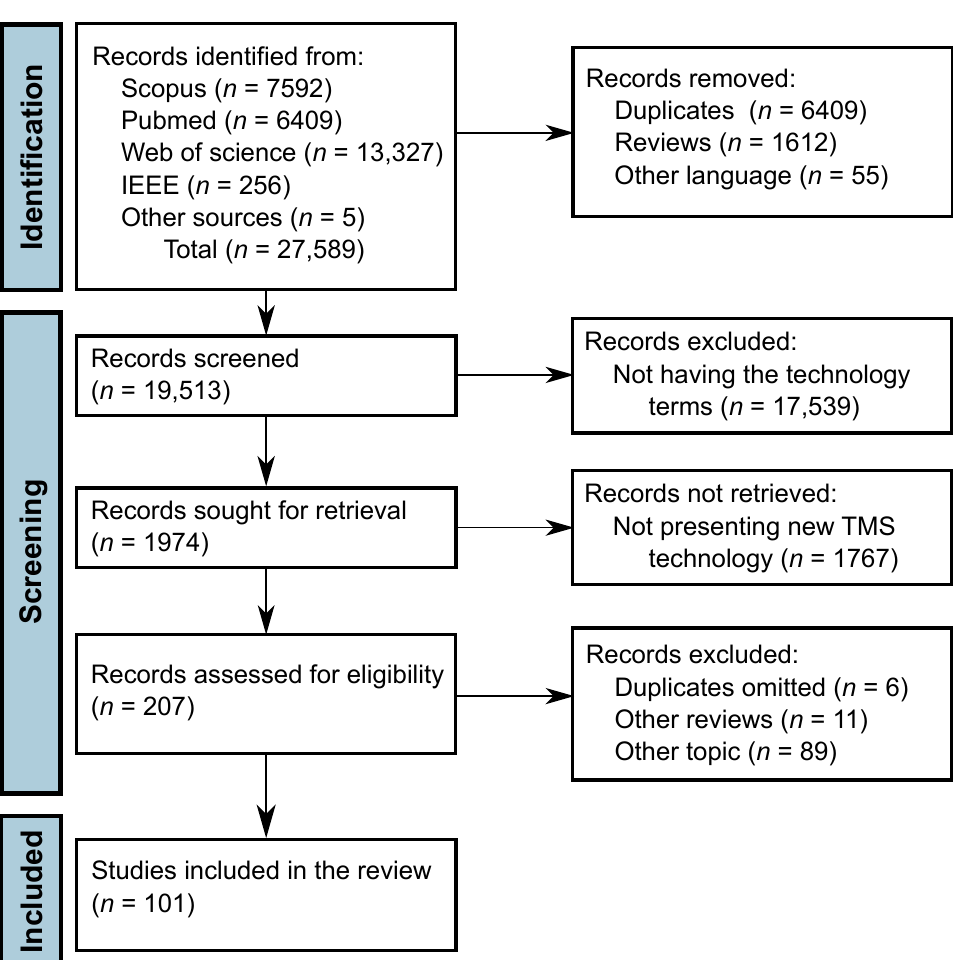
Figure 2. Flowchart of the Systematic Literature Review based on the PRISMA 2020 statement [36]. World-wide patents of TMS were consulted to determine a 2022 timestamp of the state-of-the-technique. However, full-text documents were not retrieved, since that is beyond the scope of this study. Using the terms “transcranial magnetic stimulation” in the title and abstract in the database Espacenet, we obtained 596 results. After a more specific search including the filtering terms used for the research articles (coil, device, and stimulator), the records were reduced to 291. Using the same initial terms (“transcranial magnetic stimulation”) in WIPO IP Portal, 5243 records were